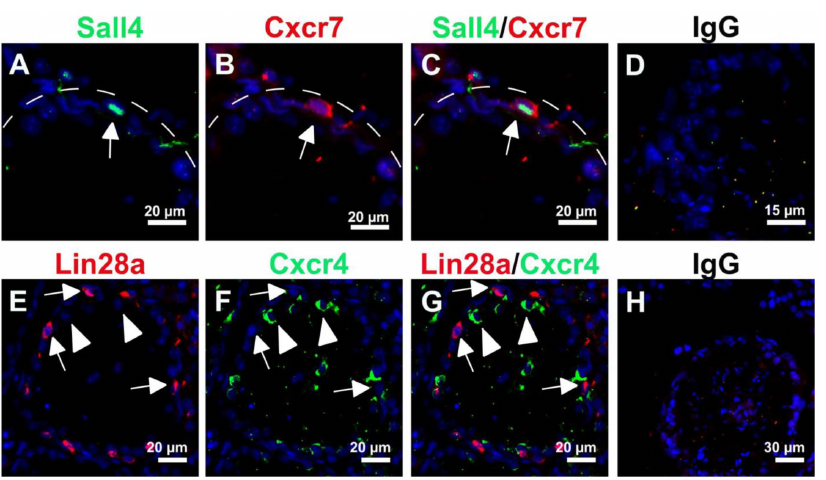
Figure 5. Cxcr7 and Cxcr4 expression in germ cell-depleted mouse testes. Representative immunofluorescence images of testicular tissue section 28 days after busulfan treatment of adult mice. Cxcr7 expression (B, red, arrow) is restricted to Sall4-positive spermatogonia (A, green, arrow) but Cxcr4 expression (F, green, arrowheads) is not solely observed in Lin28-positive spermatogonia (E, red, arrows). The respective merged images are shown in (C) and (G). Hoechst (blue) was used as nuclear counterstain. Incubation with corresponding IgG antibodies was used as negative control and a representative image is shown in (D, H). Scale bars represent 15, 20 and 30 m